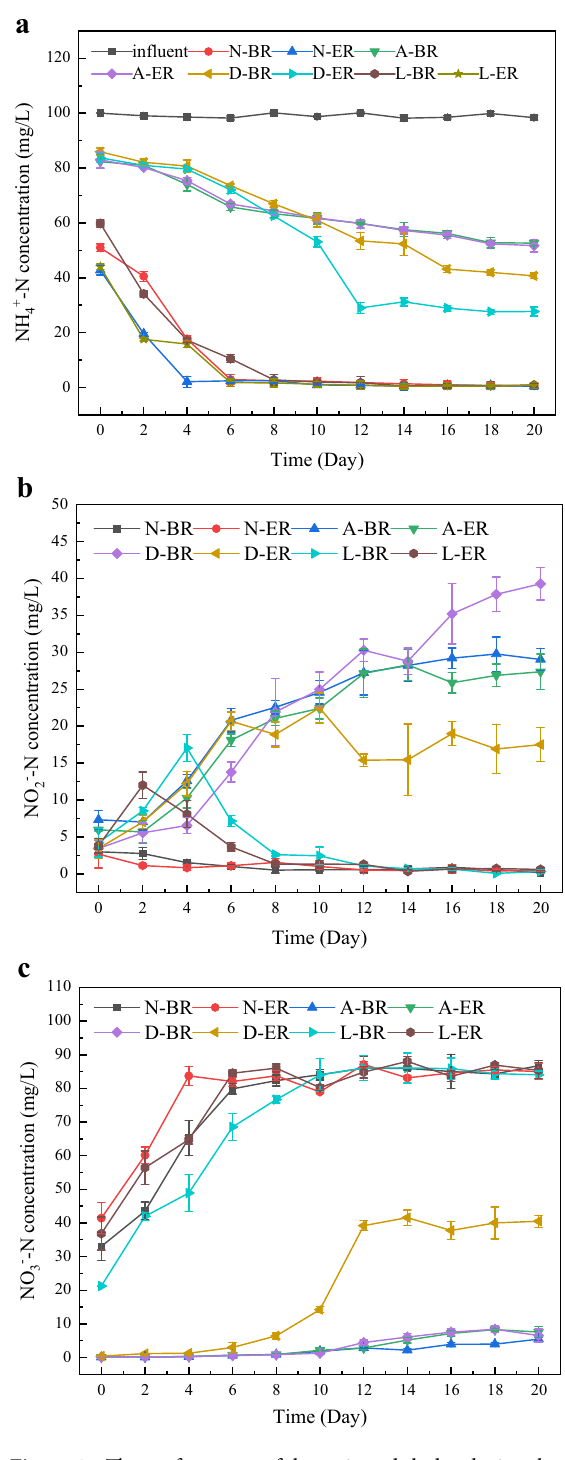
Figure 1. The performance of the activated sludge during the operation period of four groups. N normal group, A acid group, D DCD group, L low temperature group, BR blank reactor, ER experiment reactor. Error bars are defined as standard error of the mean (n = 3, biological